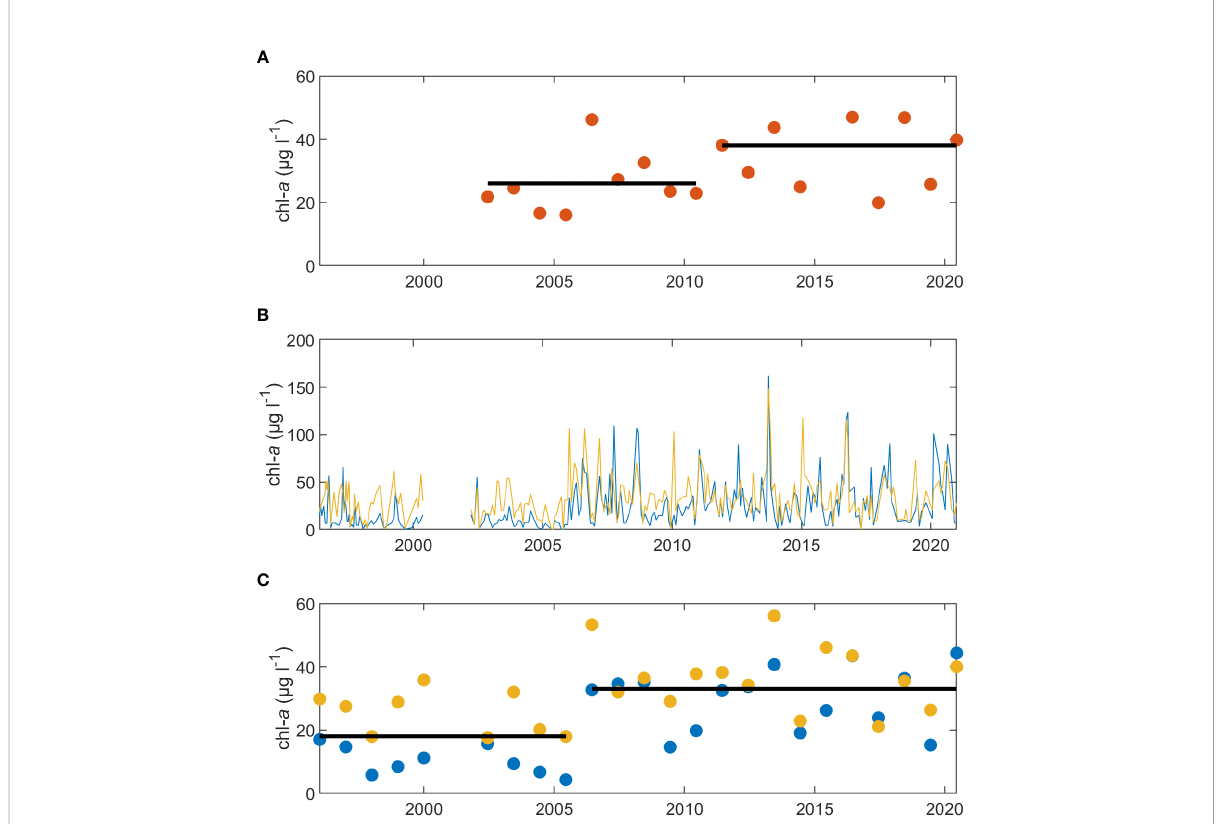
FIGURE 7 Representations of the abrupt chl- a change at the SWMP stations. Annual mean chl- a is shown for (A) the SWMP Magnolia River station (orange dots). Monthly chl- a values are shown in (B) for the 1996 to 2000 data (Pennock et al., 2001) and the SWMP Fish River (blue) and Middle Bay (yellow) stations. The data from 1996 to 2000 are graphed in the color of the matching SWMP station. Annual means are shown in (C) for the 1996-2000 data (blue and yellow dots) and the SWMP Fish River (blue dots) and Middle Bay (yellow dots) stations. The black horizontal lines in (A, C) represent overall mean chl- a over the indicated periods and were calculated from the annual